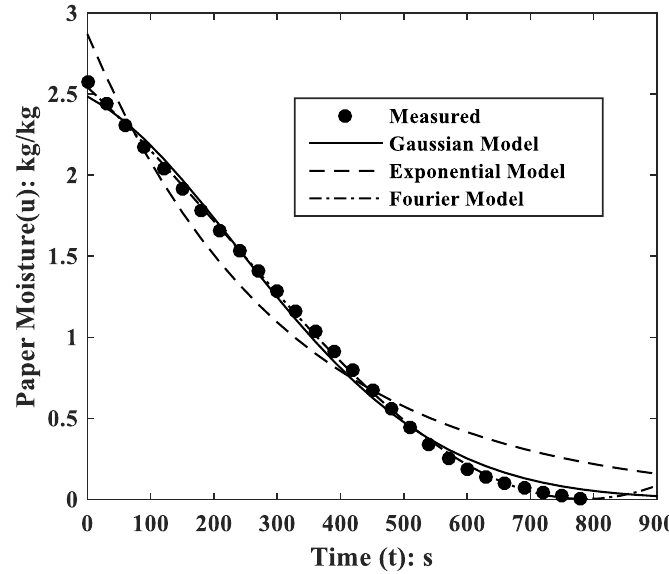
Figure 3. Measurement and analysis of drying curve in laboratory.